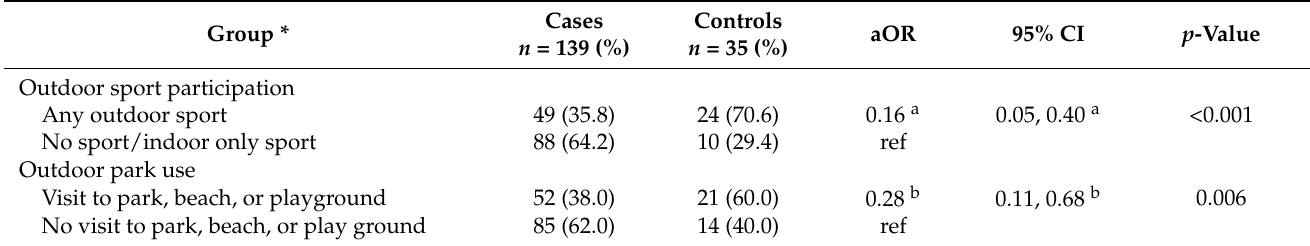
Table 2. Adjusted odds ratios for COVID-19 by outdoor sport and park